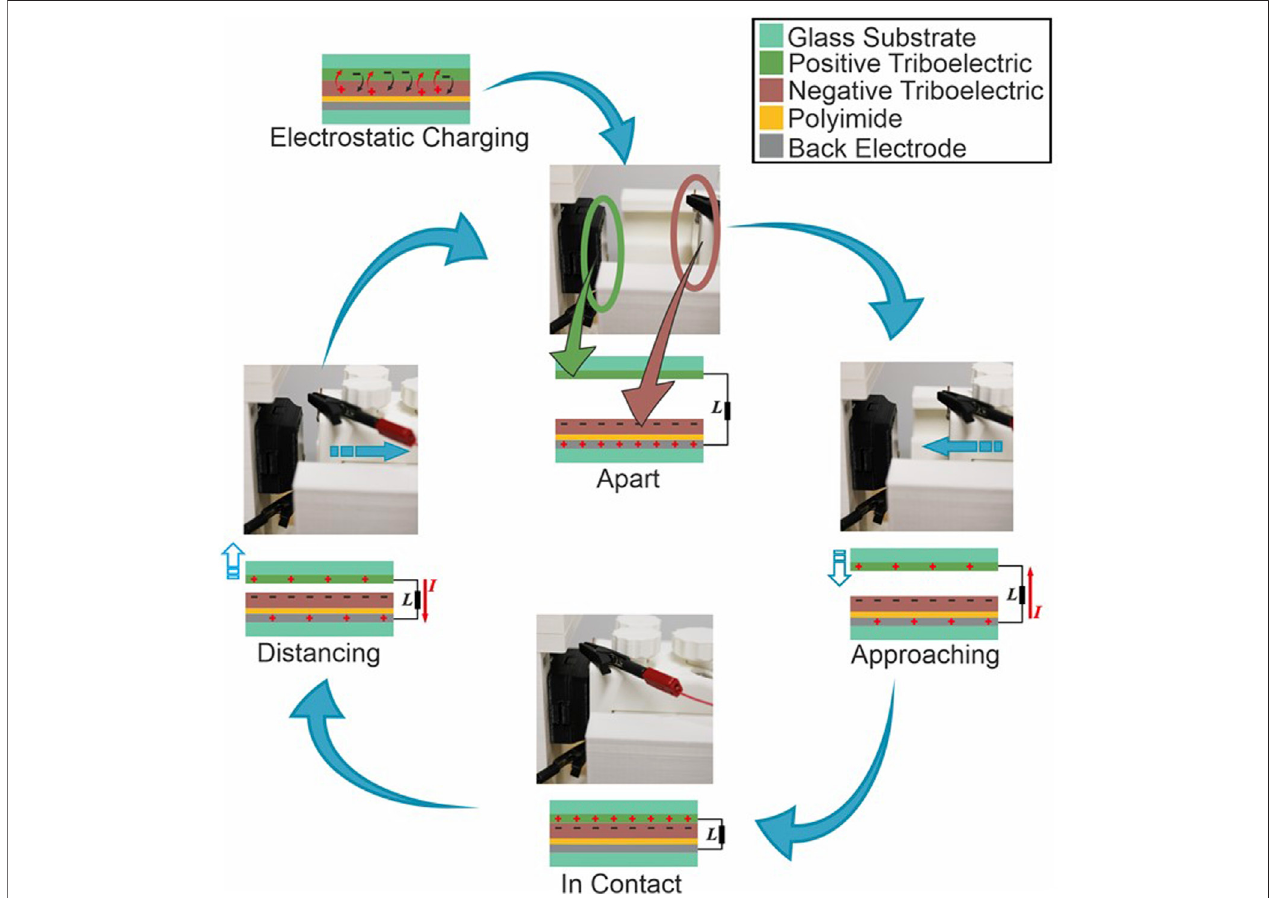
FIGURE 4 | Generic conductor-to-dielectric TENG working mechanism associated with used testing assembly.